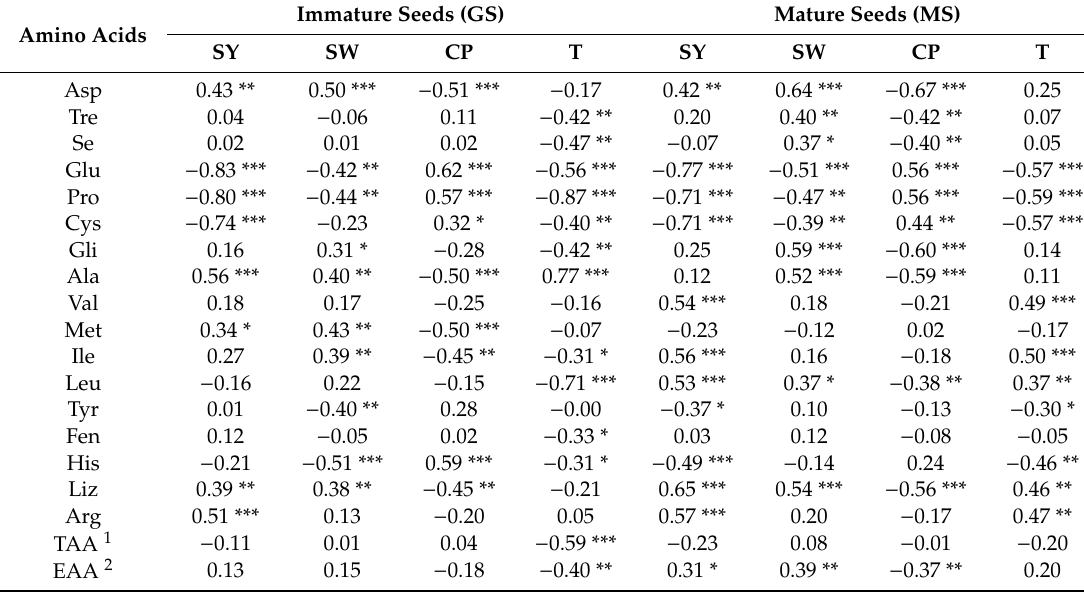
Table 8. Correlation coe ffi cient ( r ) between amino acids and seed yield (SY), seed weight (SW), crude protein (CP), and tannins (T) at two stages of seed maturity. Amino Acids